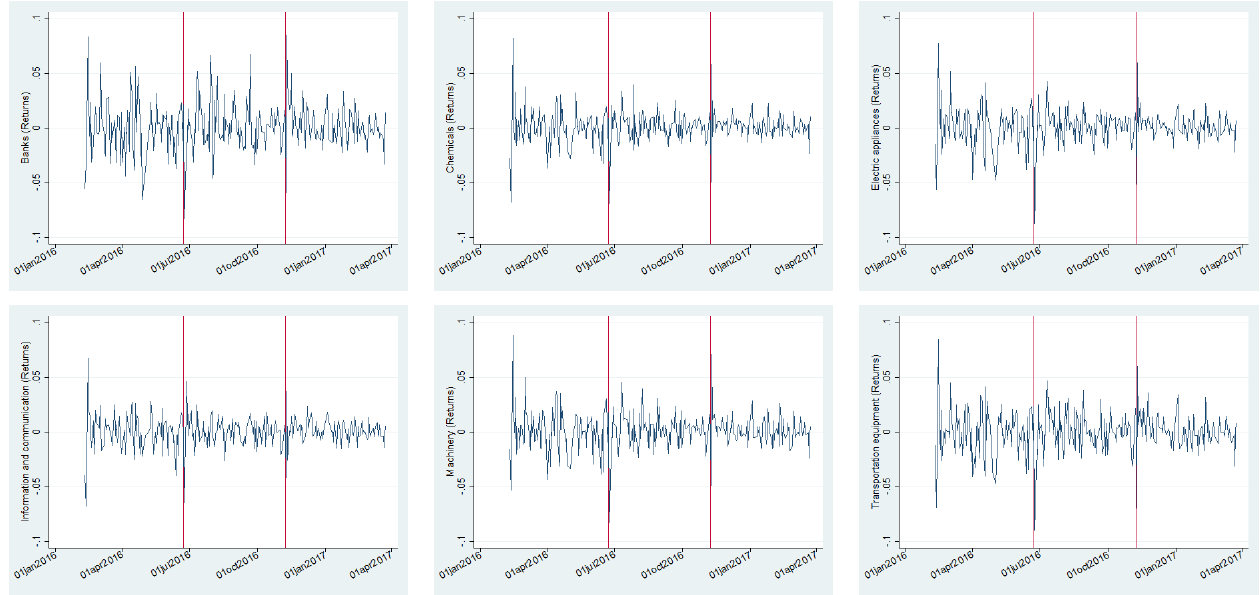
Figure 3. Returns of sectoral indices. Author’s estimations based on the data from the TSE. The returns are the daily loga- rithmic differences of the variables.